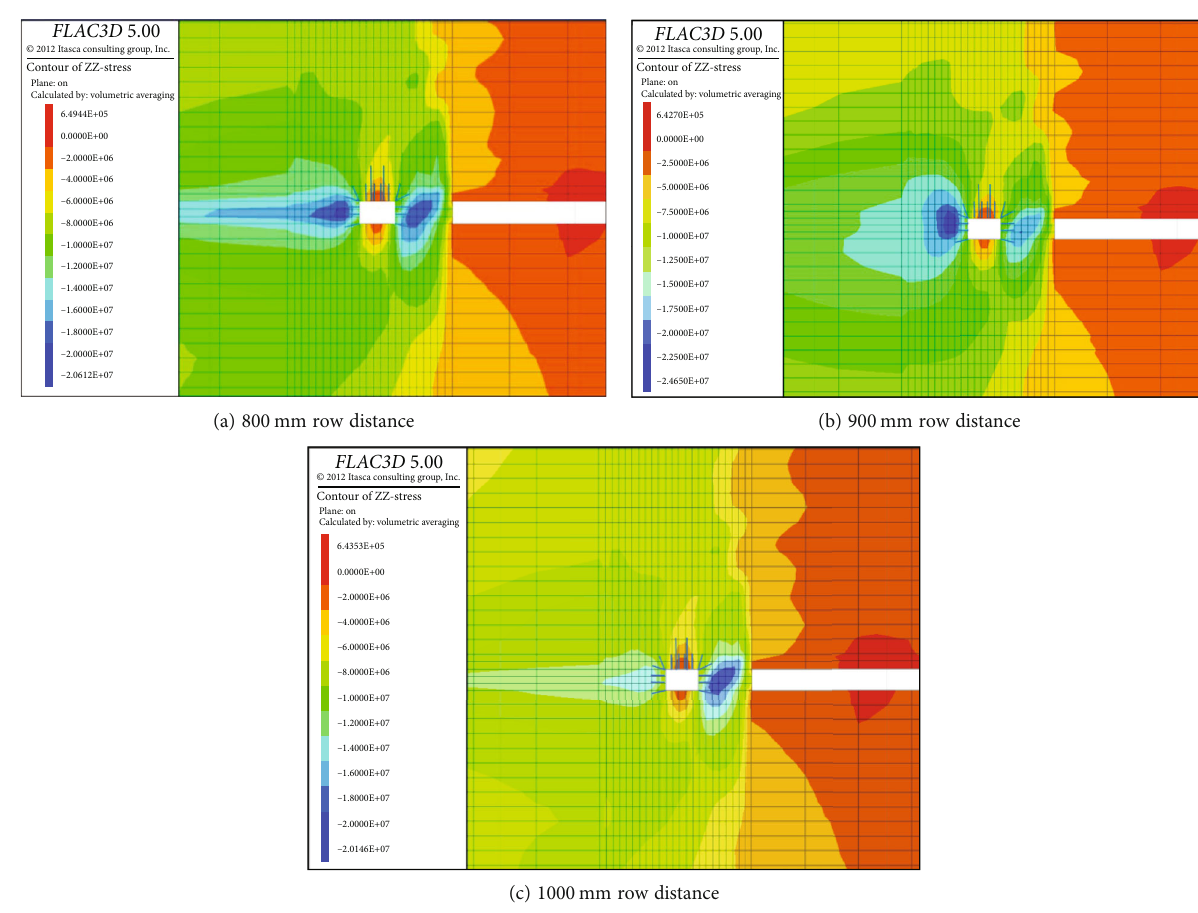
Figure 13: Vertical stress distribution in 8m width coal pillar and surrounding rock of roadway along goaf under the condition of di ff erent bolt (cable) support row distance.